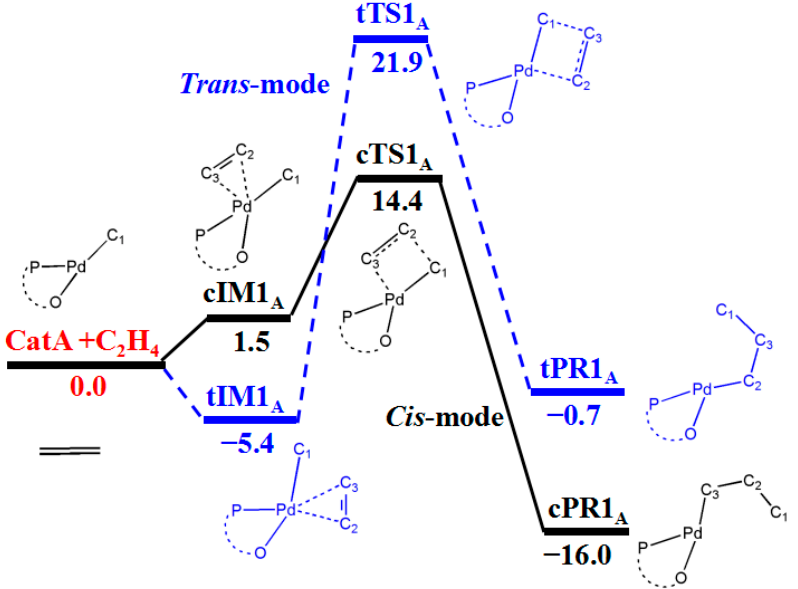
Figure 1. The reaction pathway of the first ethylene insertion, cis -mode (black) and trans -mode (blue); the relative free energy is given in kcal/mol.